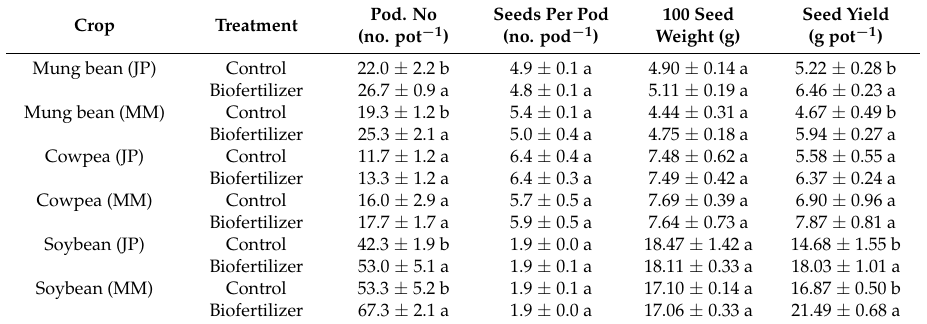
Table 10. Effect of biofertilizer on yield and yield components of mung beans, cowpeas and soybeans at R8 (maturity